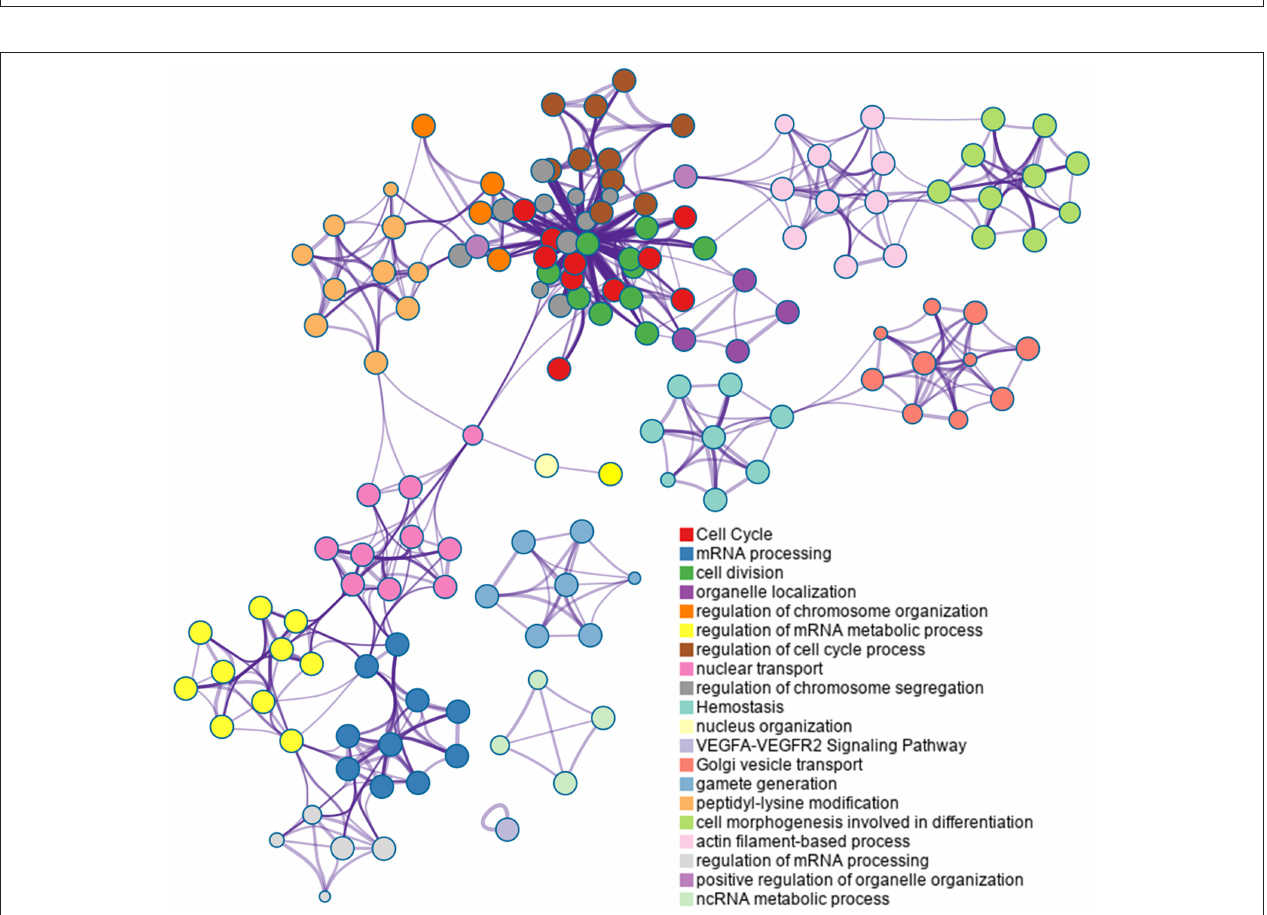
FIGURE 6 | Top 20 clusters in the enrichment network of differentially expressed proteins (DEPs). Metascape is used for annotation and enrichment visualization of DEPs. Each circle represents an enriched term and is colored according to cluster identity. Terms with a similarity score > 0.3 are linked by edges.